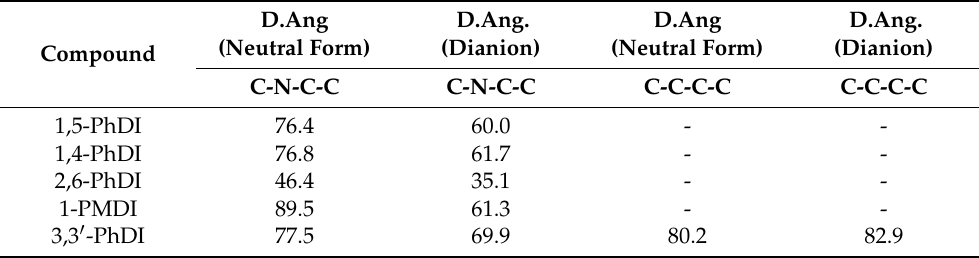
Table 8. Calculated angles between the bridge and imide groups in neutral and reduced form.